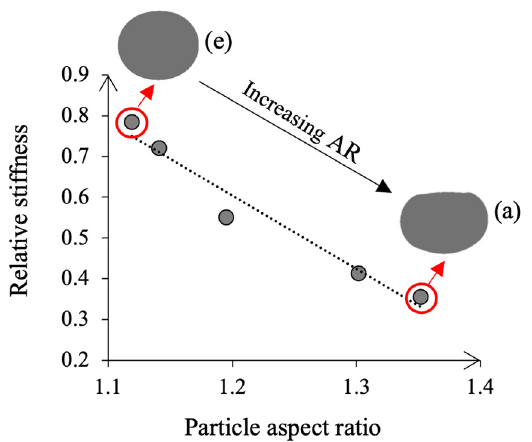
Figure 11. Correlation between the aspect ratio and the relative stiffness of the FE model and sche- schematic representation of the capsules’ deformed shape in cases (a) and matic representation of the capsules’ deformed shape in cases (a) and (e).